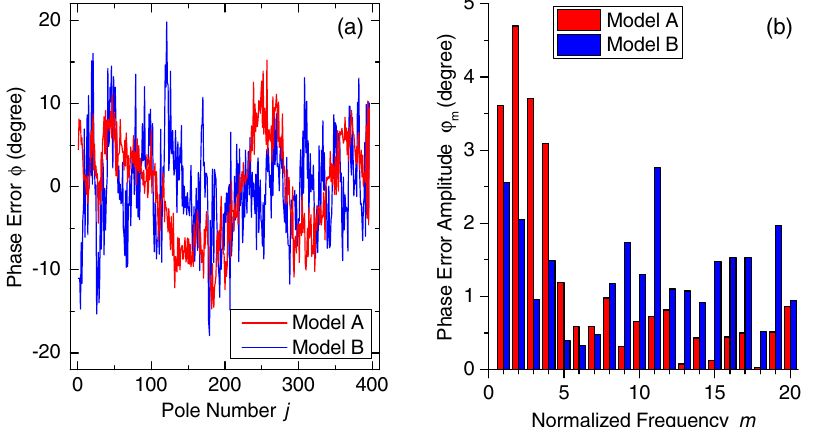
FIG. 3. Examples of undulator models having the same phase error σ ϕ of 6° in terms of (a) the phase error ϕ j plotted as a function of the pole number j and (b) the phase error amplitude φ m plotted as a function of the normalized frequency m .